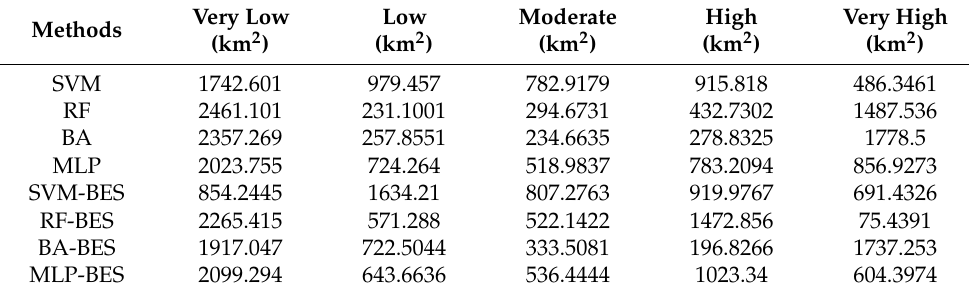
Table 3. The distribution of each class with the different